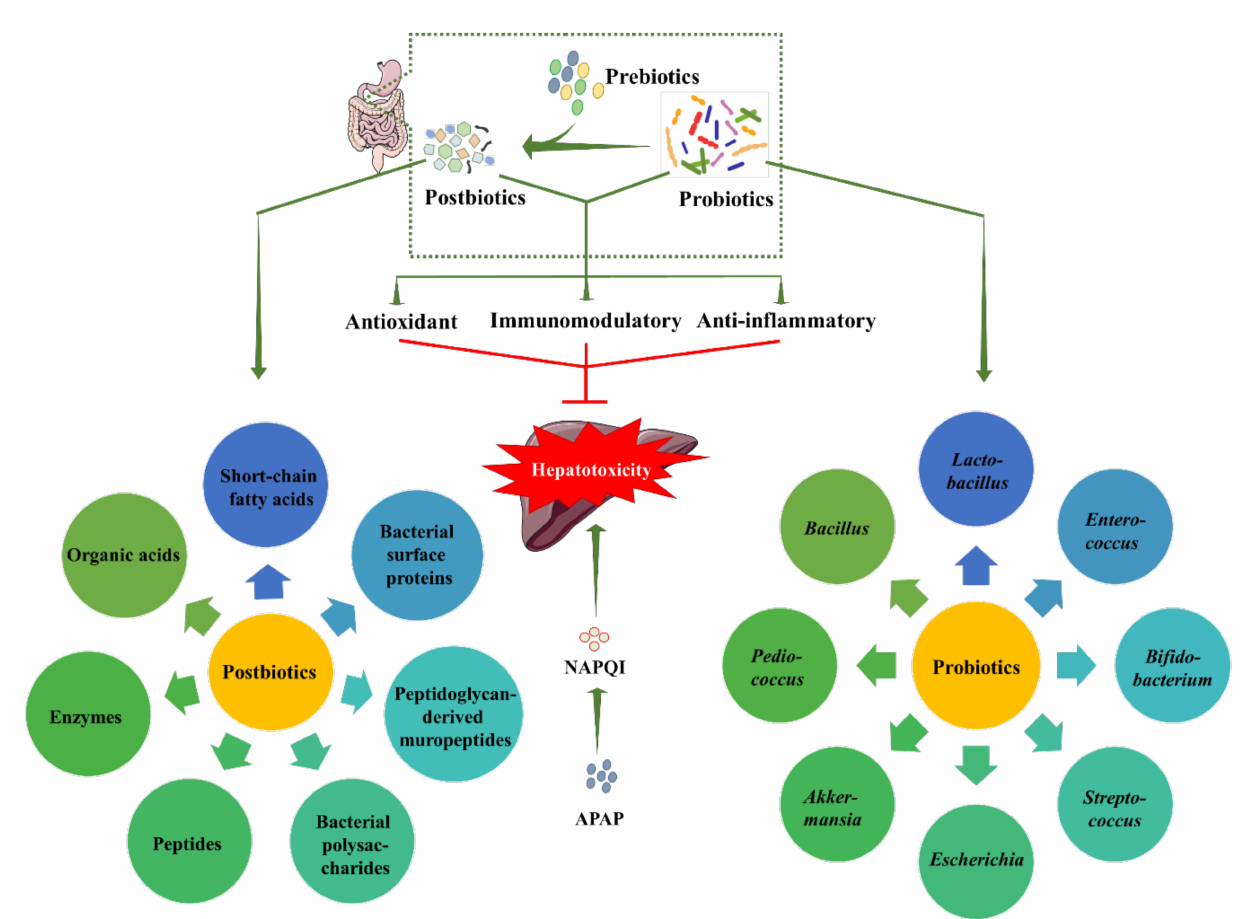
Figure 4. A schematic view of overall protective roles of probiotics and postbiotics against APAP hepatotoxicity. Beneficial bacterial species, known as probiotics, use their innate probiotic capabil- ities to improve liver health. Some species under the genus Lactobacillus , Bifidobacterium , Bacillus , Streptococcus , Enterococcus , Akkermansia , Escherichia , Pediococcus , etc., have been categorized as probi- otic bacteria. Postbiotics are either microbial components or soluble biologically active metabolites that are generally produced by probiotics by using prebiotics. Probiotics and postbiotics ensure hepatoprotective effect against APAP-induced hepatotoxicity by the antioxidant, anti-inflammatory, and immunomodulatory mechanisms. Green arrows represent downstream events. APAP: ac- etaminophen, NAPQI: N-acetyl p-benzoquinone